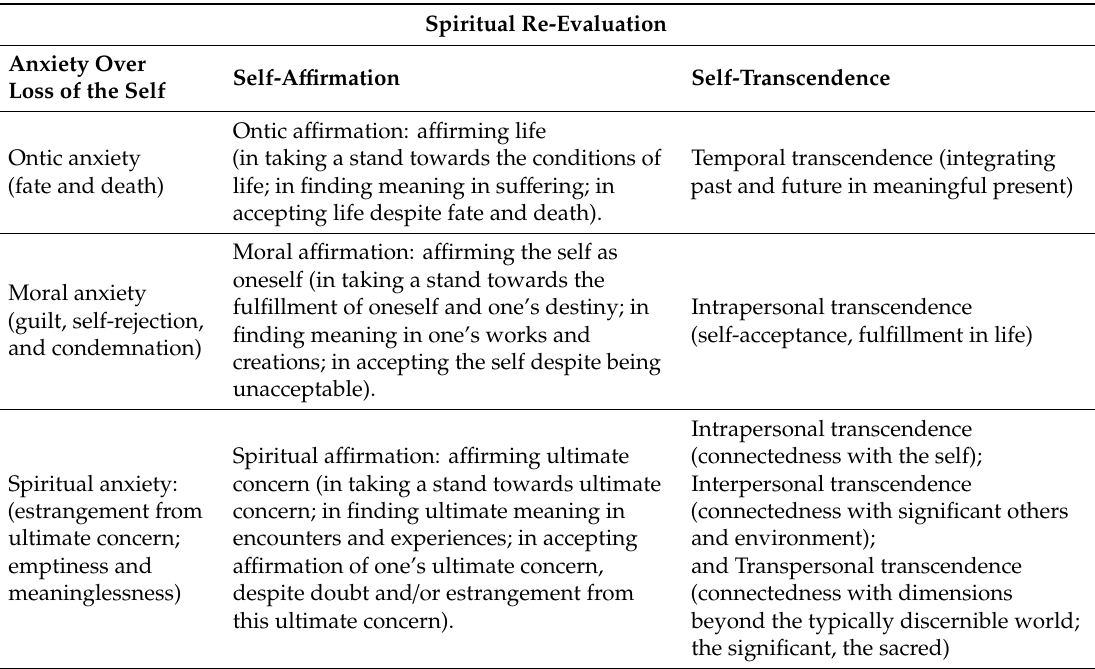
Table 1. Spiritual re-evaluation and